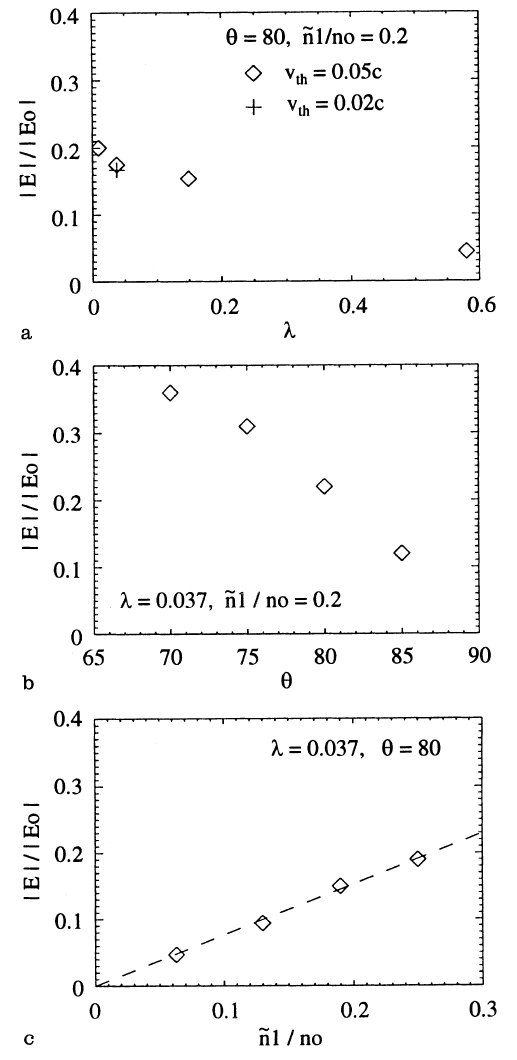
Fig. 8a–c. Ratios of the excited wave amplitude to the pump amplitude given by the simulations. The variable parameters are a (cid:107) and v th , b (cid:104) , and c n 1 , respectively. The dashed line in c is a linearly fitted line